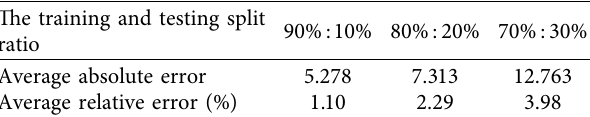
Figure 5: The relative errors of different algorithms. Table 4: Prediction results of different training and testing split